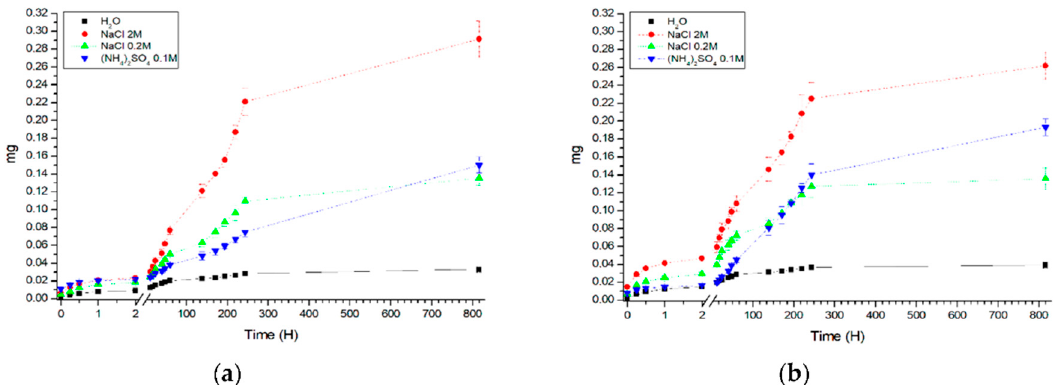
Figure 1. Dependence of the mass of the FITC-labeled PAH in the supernatant on the incubation time of polyelectrolyte microcapsules at room temperature (22 ◦ C) ( a ) and at 37 ◦ C ( b ) in the presence of